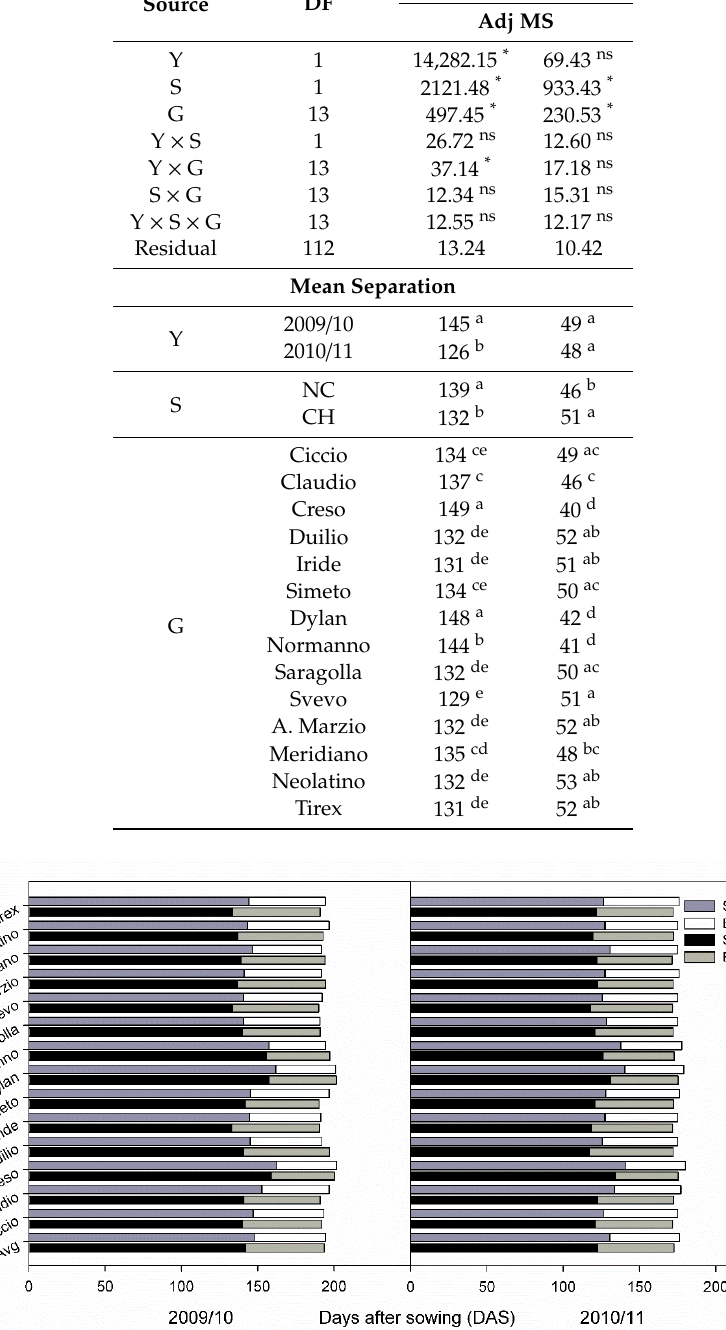
Figure 2. Main crop phenological phases (S-E and E-Pm) of durum wheat genotypes under conventional (CH) and no-chemical input (NC) management systems in two growing seasons (2009/10 and 2010/11). Genotype times management system interaction per p ≤ 0.05 (LSD 0.05 : 6.01 and 2.79 for S-E, 5.00 and 3.05 for E-Pm in 2009/10 and 2010/11 growing seasons, respectively).